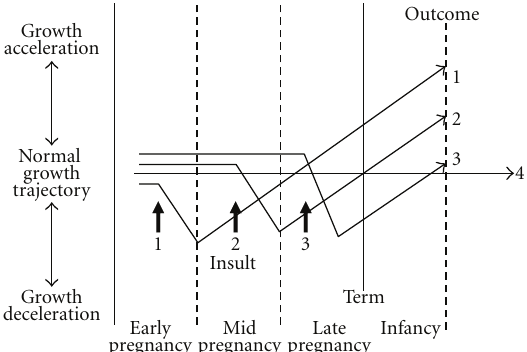
Figure 1: Schematic diagram demonstrating how growth decel- eration at di ff erent gestations with resulting “catch-up growth” may result in low, normal, or high birth weight. Insult 1 in early pregnancy results in initial growth deceleration followed by growth acceleration during mid and late pregnancy and post natal life and is associated with increased birth weight (Outcome 1). Insult 2 occurs during mid pregnancy and results in growth deceleration followed by growth acceleration during later pregnancy and infancy, associated with normal birth weight (Outcome 2). Insult 3 occurs during late pregnancy leading to with low birth weight and ensuing “catch-up growth” during infancy (Outcome 3). Outcome 4 illustrates normal growth throughout pregnancy and